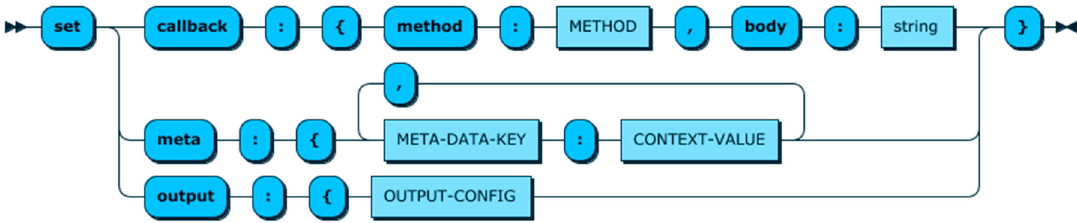
Figure 14. SET clause production rule.